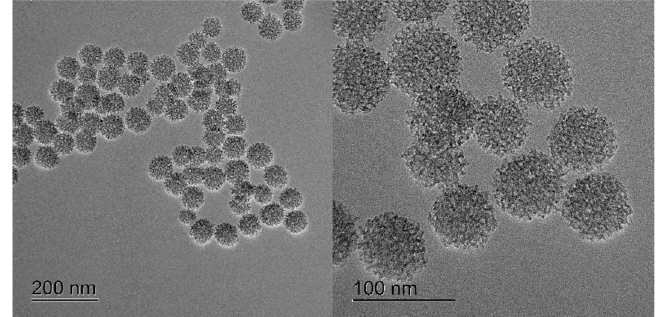
Figure 1. TEM images of: ( A ) MSN , ( B ) MSN-1c , ( C ) MSN-3c and ( D ) MSN-4a .